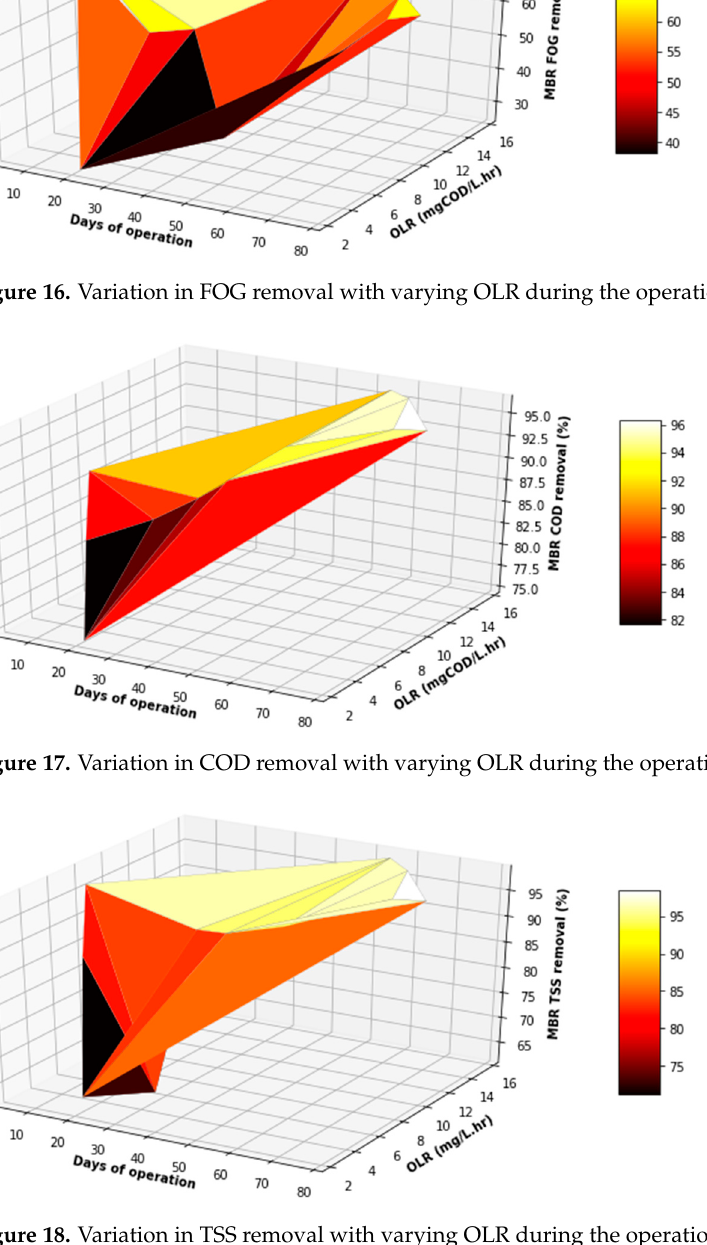
Figure 18. Variation in TSS removal with varying OLR during the operation of the MBR.